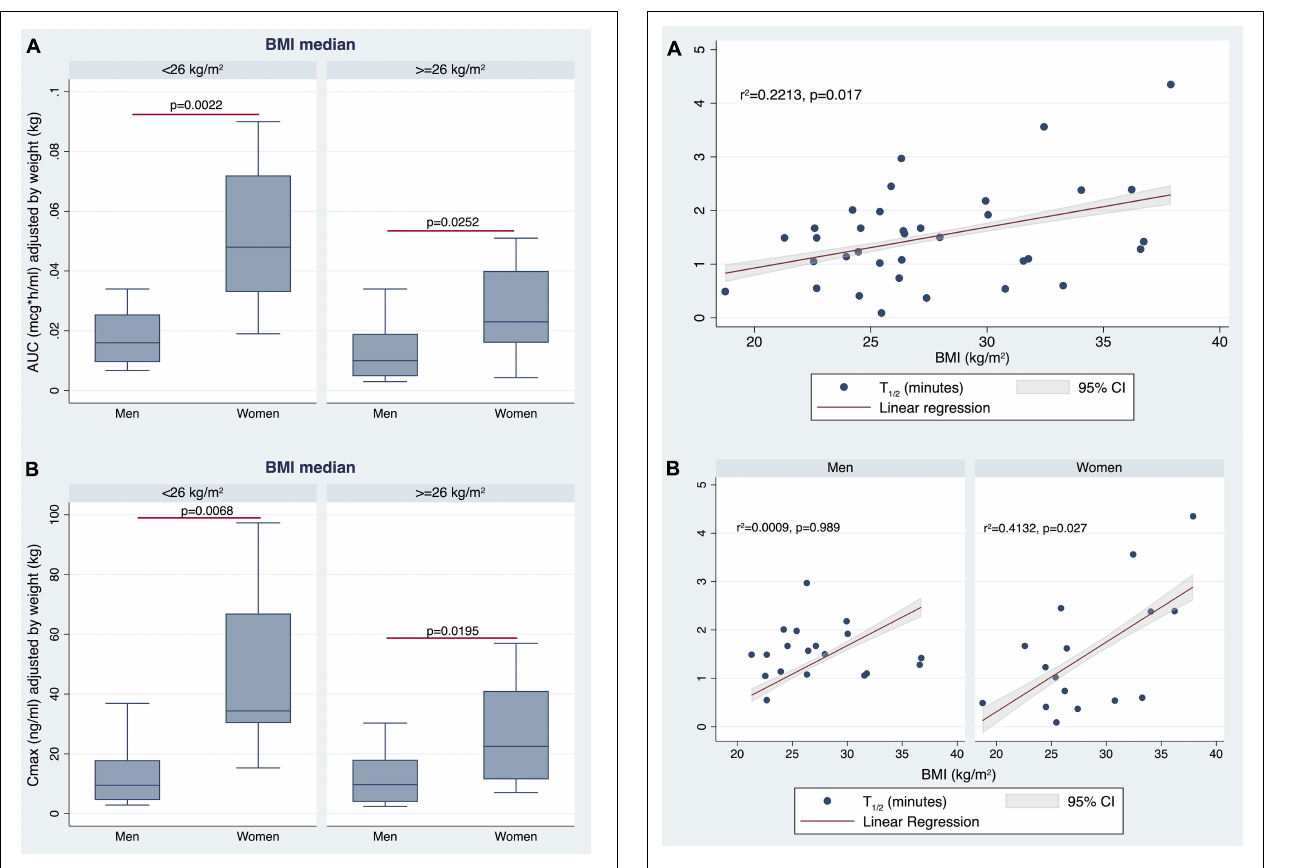
FIGURE 7 | Gender differences observed in AUC (A) and Cmax (B) , adjusted for BW, by stratifying the study population according to median BMI value.